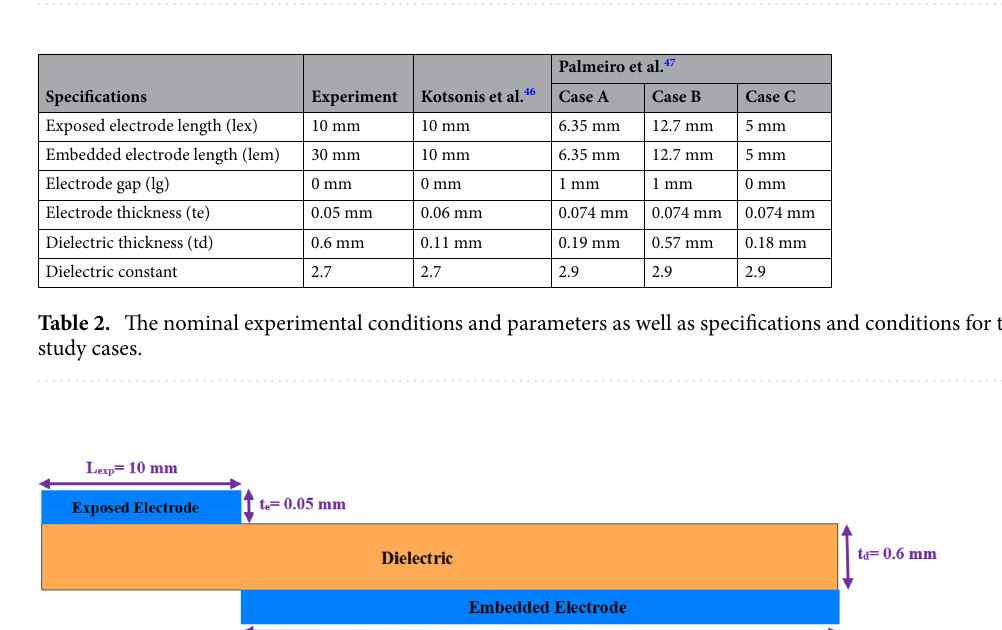
Figure 4. A DBD actuator schematic including the boundary conditions for electrostatic simulation.